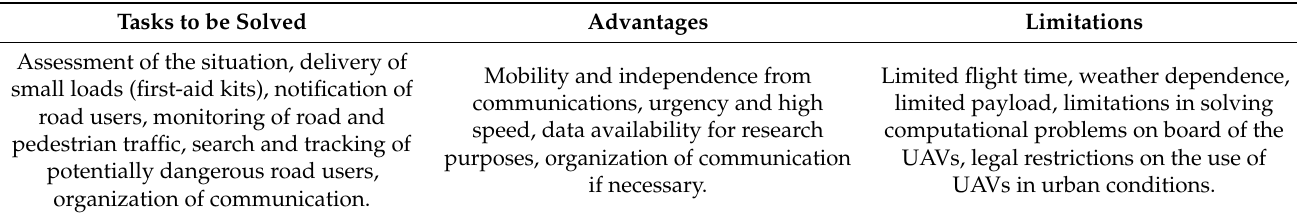
Table 2. Pros and cons of UAV applications in traffic monitoring processes.